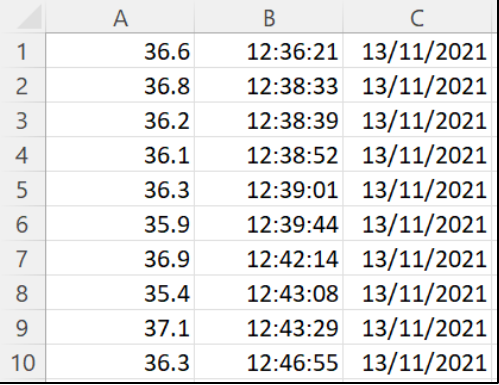
Figure 11. Body temperature information saved in the cloud server and displayed via CSV